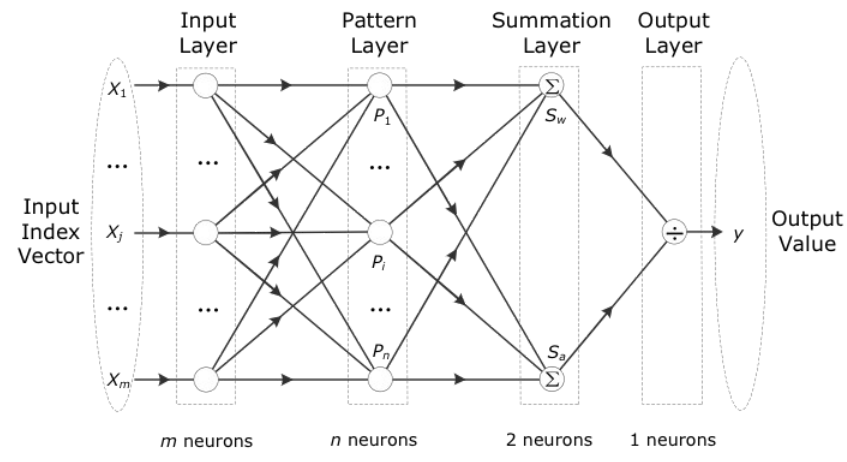
Figure 1. Topological structure of GRNN